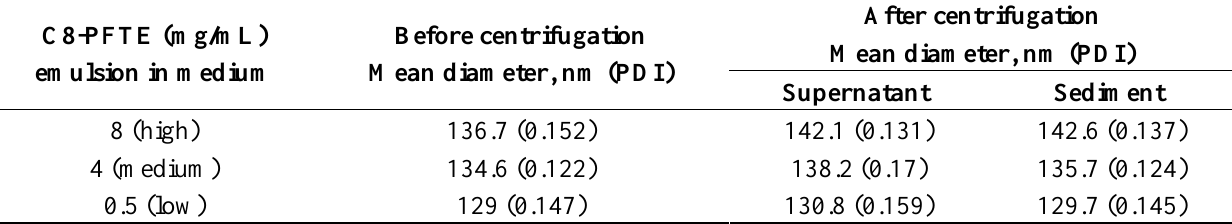
in the cell culture medium, before and after centrifugation at 2,000 rpm for 10